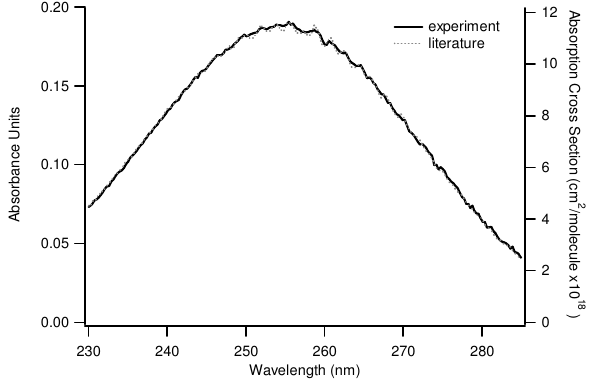
Fig. 5. The UV absorption spectrum of the Hartley band of ozone measured with an AE-DOAS path length of 9.75m is shown as a solid black line. This is compared to the dotted grey line showing the absorption cross section spectrum of ozone (shown on the right y-axis) (Bogumil et al., 2003). A wavelength adjustment equivalent to adding one nanometer to the experimental spectrum is required to match the fine spectral structure seen in the literature spectrum.